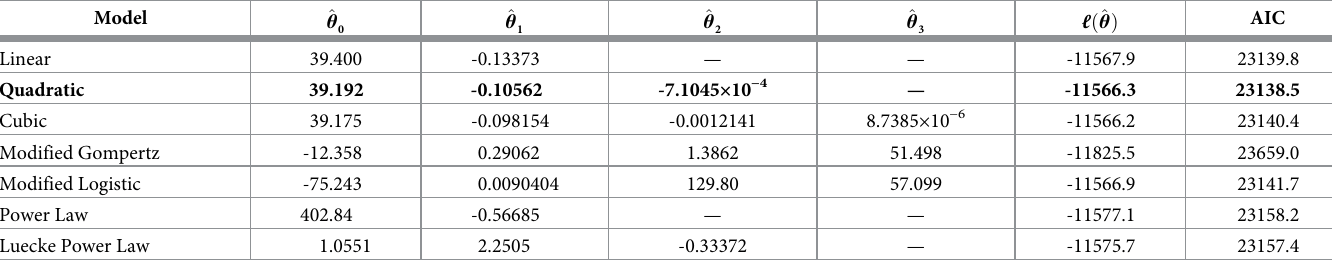
Table 16. Maternal hematocrit models (percentage vs. maternal mass in kg for power law models, percentage vs. gestational age in weeks for all other models).